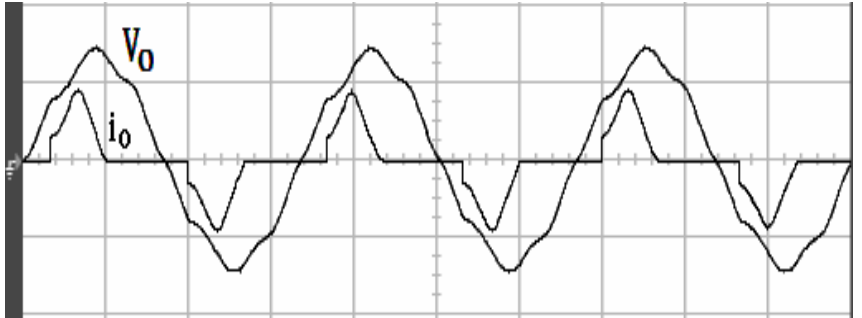
Figure 11. Output voltage and current for experiment of the conventional limited ‐ time convergent VSC under rectifier load (vertical: 100 V/div and 25 A/div; horizontal: 5 ms/div).